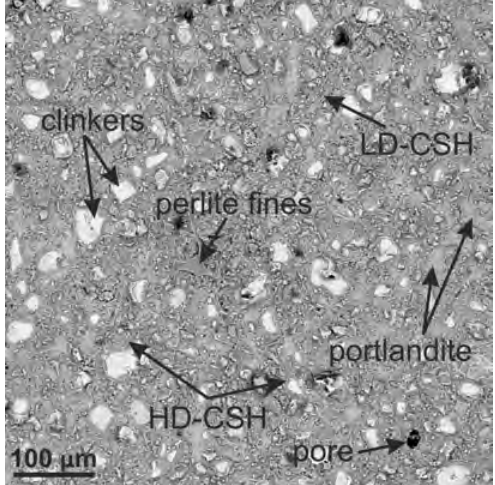
Figure 2. BSE micrograph showing microstructure of cement paste with perlite addition.